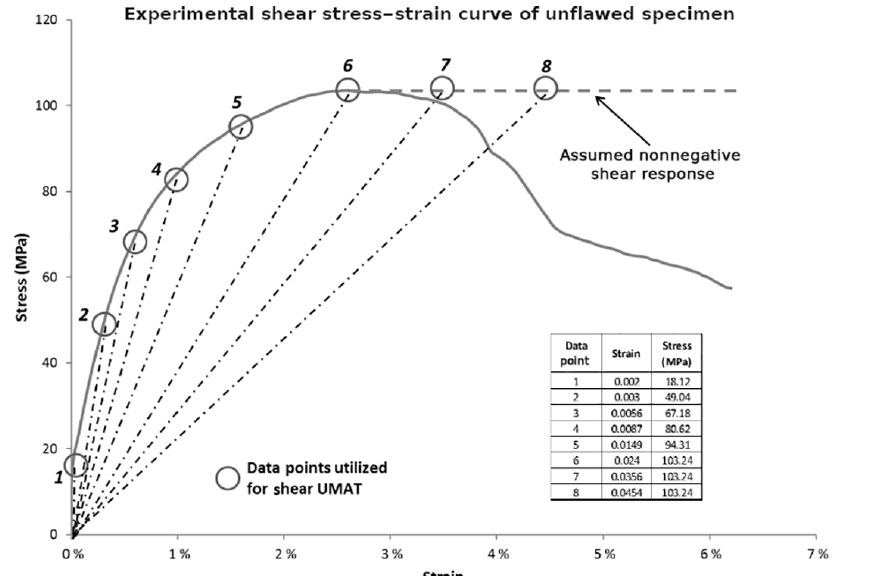
Figure 3. Key points from empirical shear stress–strain relationship used in the nonlinear shear UMAT.